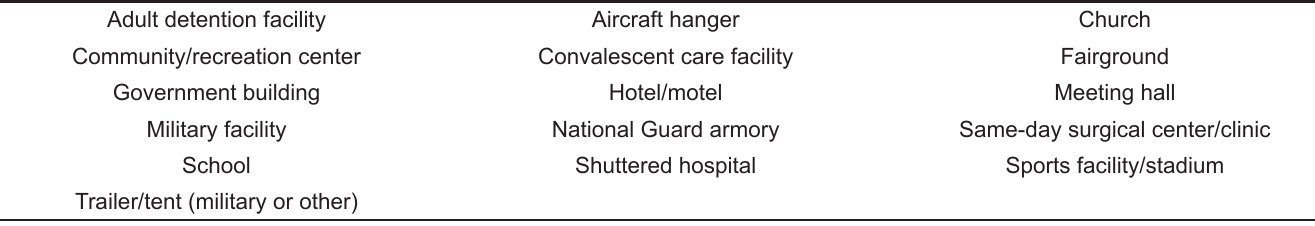
Table 1. Buildings/structures typically used as alternative care sites during disasters.